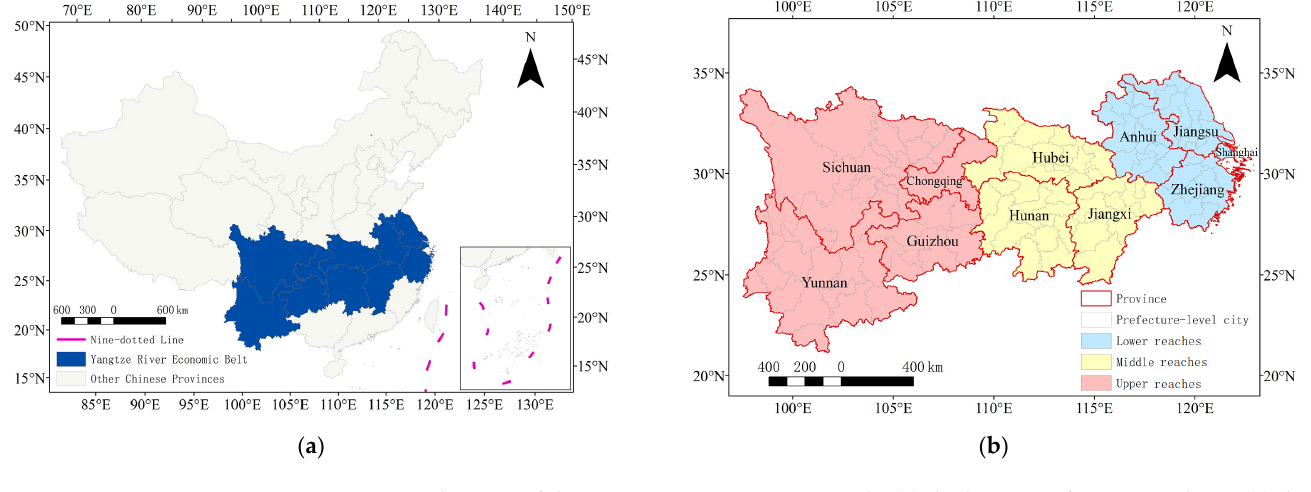
Figure 1. The map of the Yangtze River Economic Belt: ( a ) the location of YREB in China; ( b ) the administrative regions of YREB.